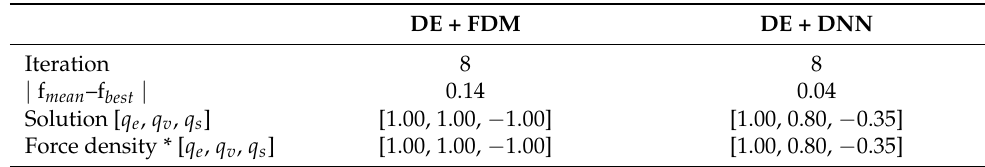
Figure 25. Relationship between the iteration and error of the 3D truncated icosahedron tensegrity using an FDM and a DNN-based form-finding model with a DE algorithm. Table 8. The final results of the 3D-truncated icosahedron tensegrity using an FDM and a DNN-based form-finding model with a DE